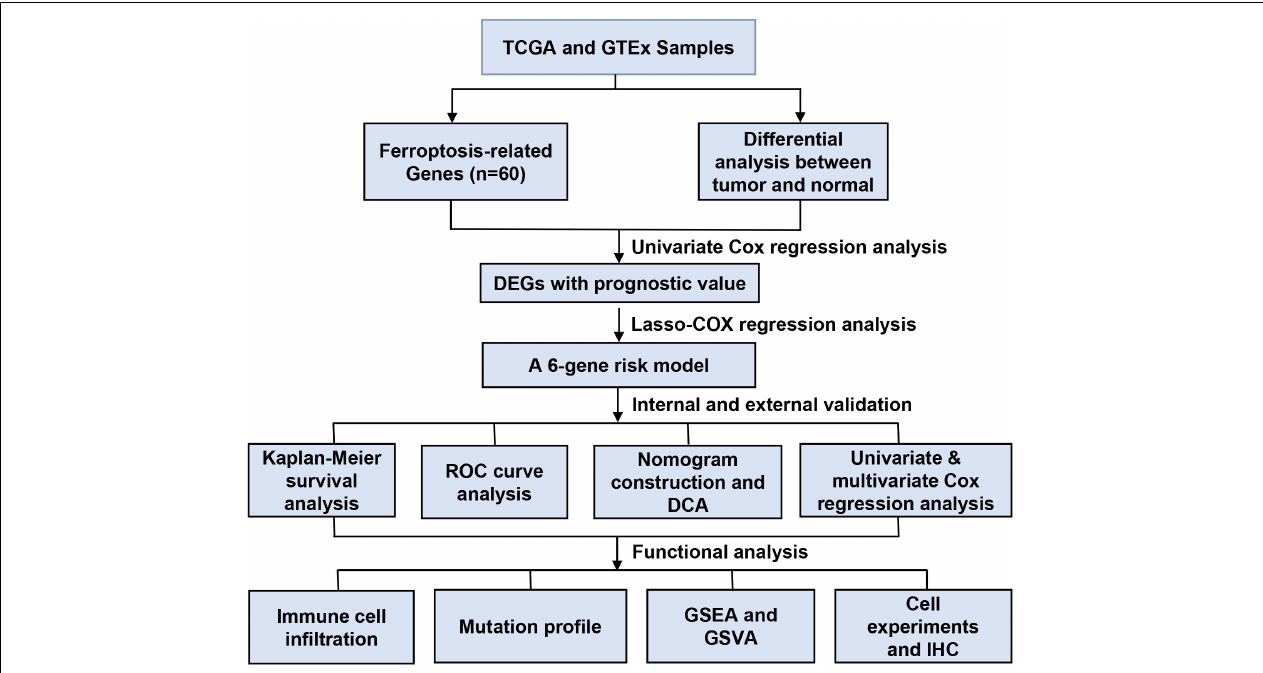
FIGURE 1 | Data processing flow